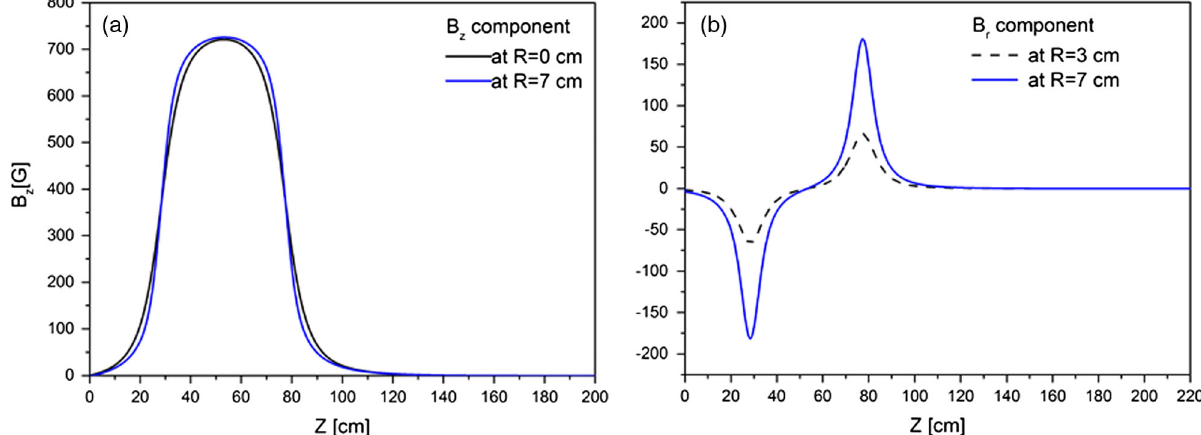
FIG. 3. Simulated magnetic fields used in the simulation for a 201 A driving current on the extraction solenoid when the bucking coil current is chosen to minimize the on axis magnetic field at the velvet cathode; (a) B z at R ¼ 0 cm (black line) and R ¼ 7 cm (blue line) as a function of Z ; (b) B r component at two different radii: at R ¼ 3 cm (black dashed line) and R ¼ 7 cm (blue line).